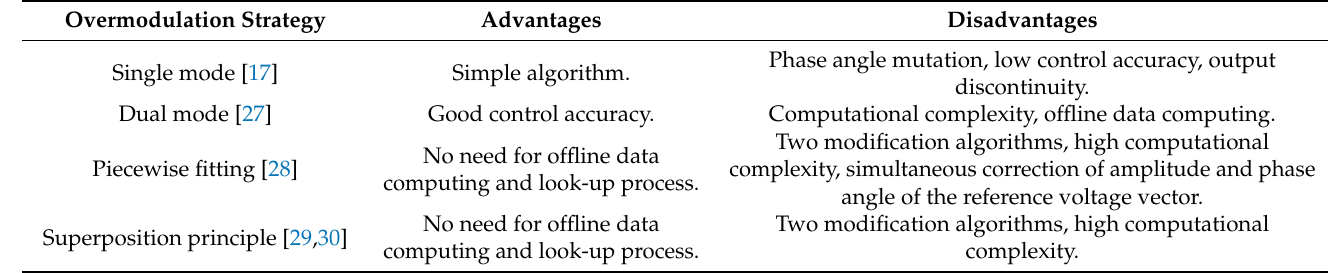
Table 1. Comparison of state-of-the-art methods. Overmodulation Strategy Advantages Disadvantages Phase angle mutation, low control accuracy, output Single mode [17] Simple algorithm. discontinuity. Dual mode [27] Good control accuracy. Computational complexity, offline data computing. Two modification algorithms, high computational No need for offline data Piecewise fitting [28] complexity, simultaneous correction of amplitude and phase computing and look-up process. angle of the reference voltage